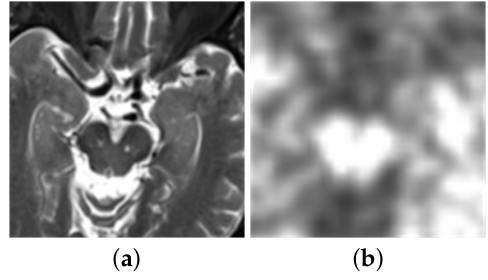
Figure 9. ( a ) Original MRI image. ( b ) Original PET